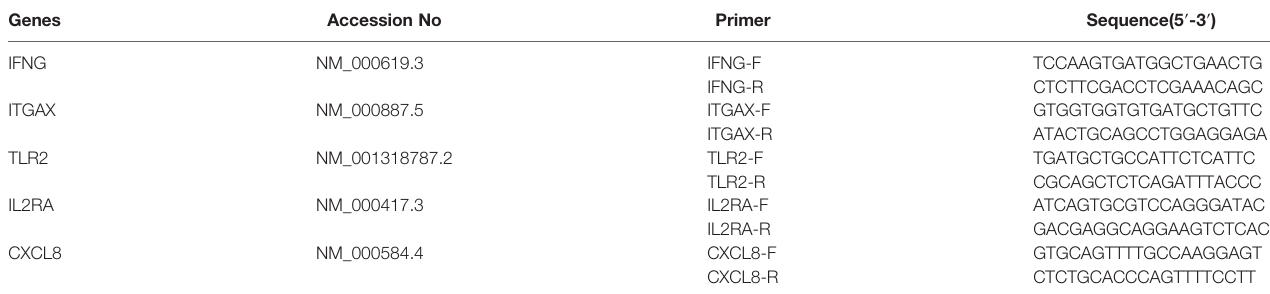
TABLE 1 | Primers for hub genes validated using reverse transcription polymerase chain